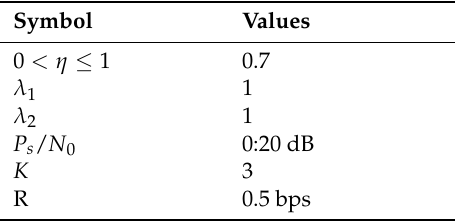
Table 2. Simulation